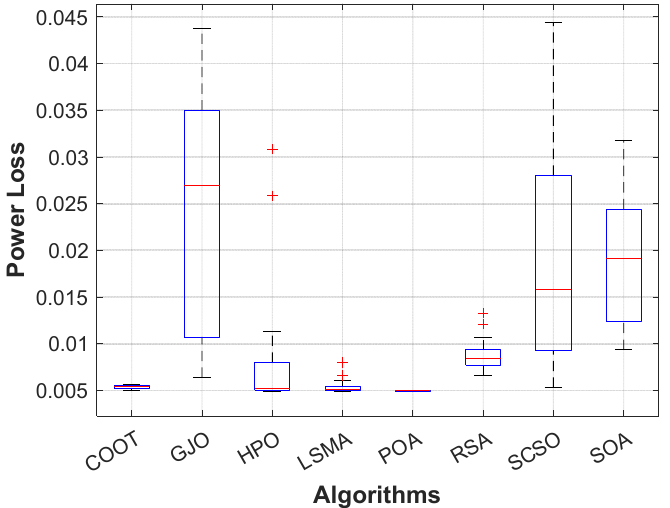
Figure 8. Boxplot of POA and other compared algorithms for case 2 in a standard IEEE 14-bus test system.